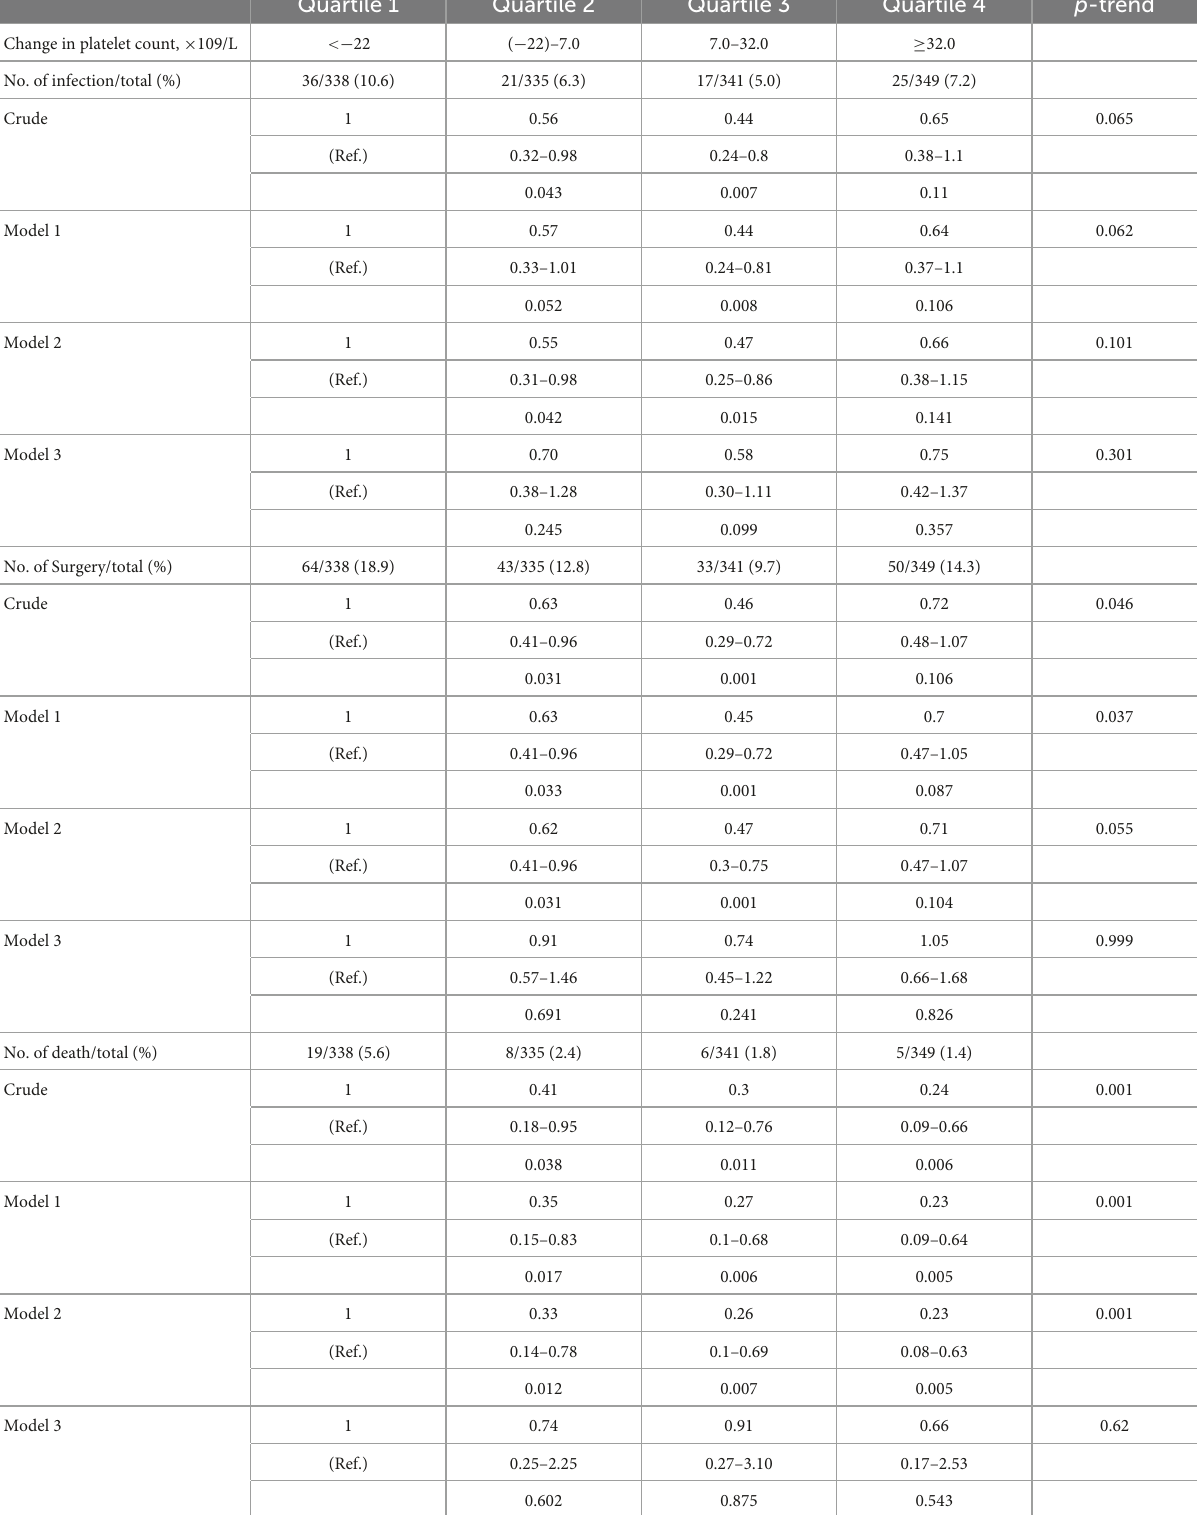
TABLE 4 Association between the changes in platelet count within the first 3 days after admission and risk of intra-abdominal infection, surgical intervention, and in-hospital mortality estimated using logistic regression